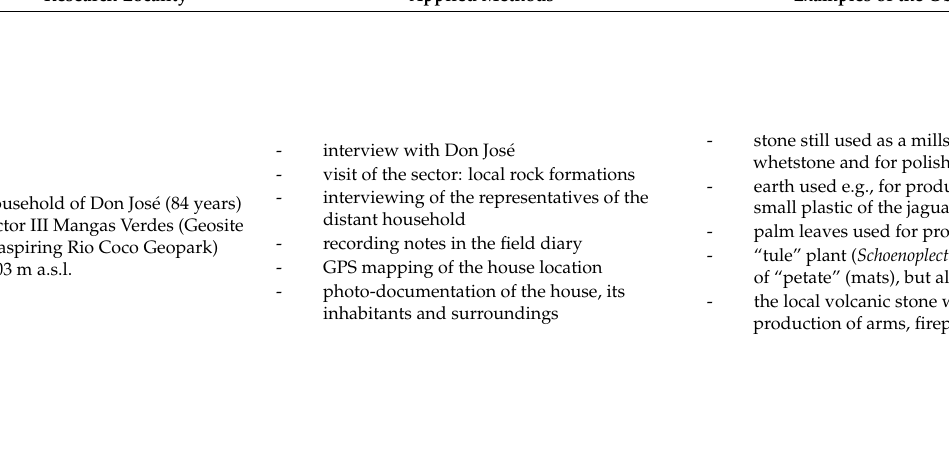
houses and for borders marking (“mojones”)  earth used: e.g., for production of “adobe” bricks (clay with pine needles dried in the sun), “ladrillo” bricks (clay with cow dung burnt in the oven) and ceramics  local plants used for medicine: e.g., “jiñocuabo” or “indio desnudo” ( Bursera simaruba )—the leaves of this tree have anti-inflammatory effects, these trees serve also as “barrera viva” (living fence)